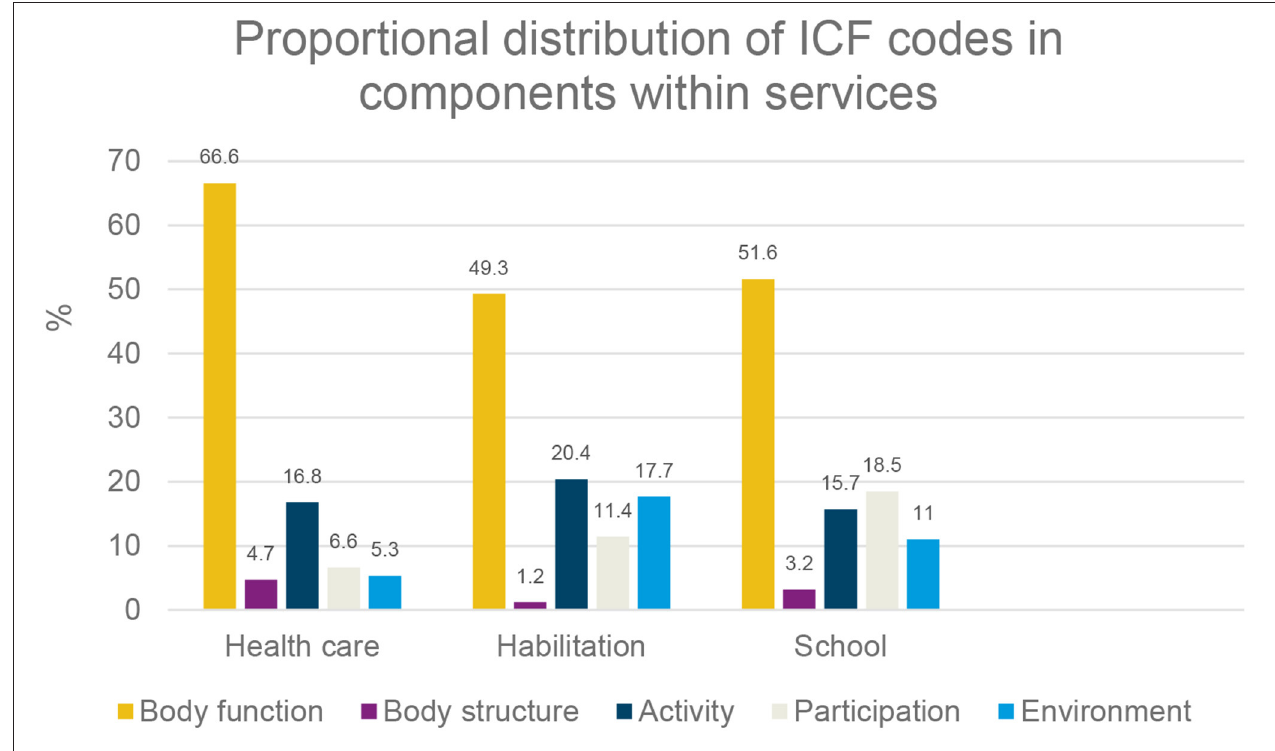
FIGURE 1 | Distribution of codes in the ICF components within